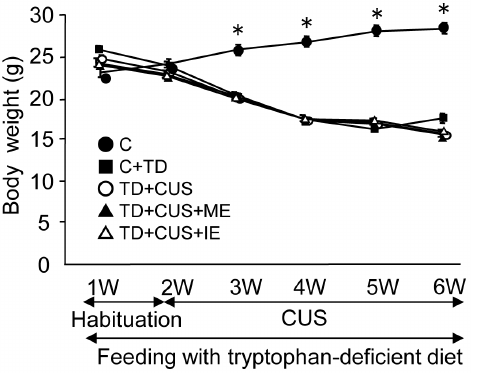
Figure 2. Effects of tryptophan deficiency, CUS and regular exercise on body weight. Data are expressed as mean 6 SEM. *, p , 0.05 vs. TD, TD + CUS, TD + CUS + ME, TD + CUS + IE; TD + CUS; m , TD + CUS + ME; g , TD + CUS + IE.